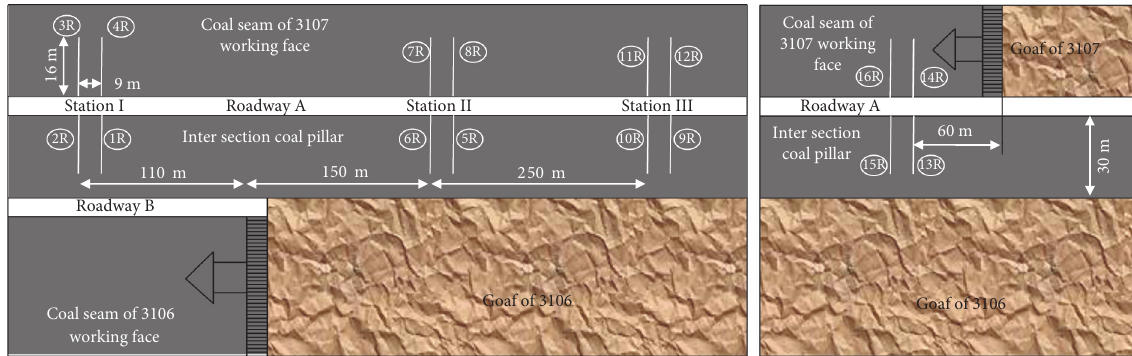
Figure 7: Layout of testing stations.